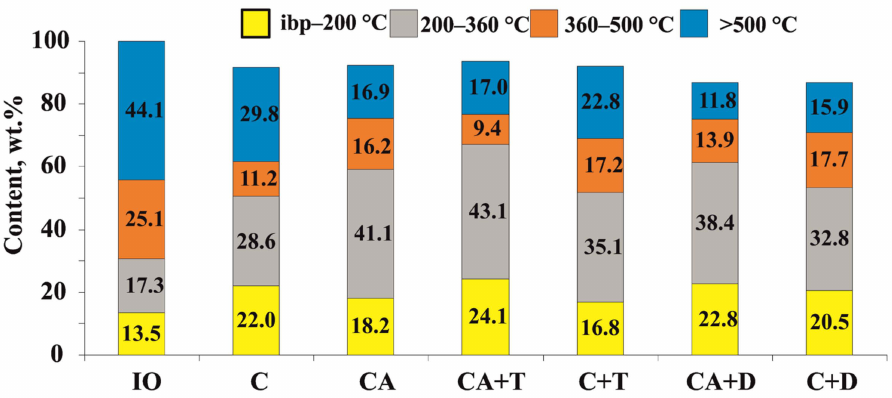
Figure 1. Fractional composition of the products of catalytic aquathermolysis of heavy oil in the presence of hydrogen